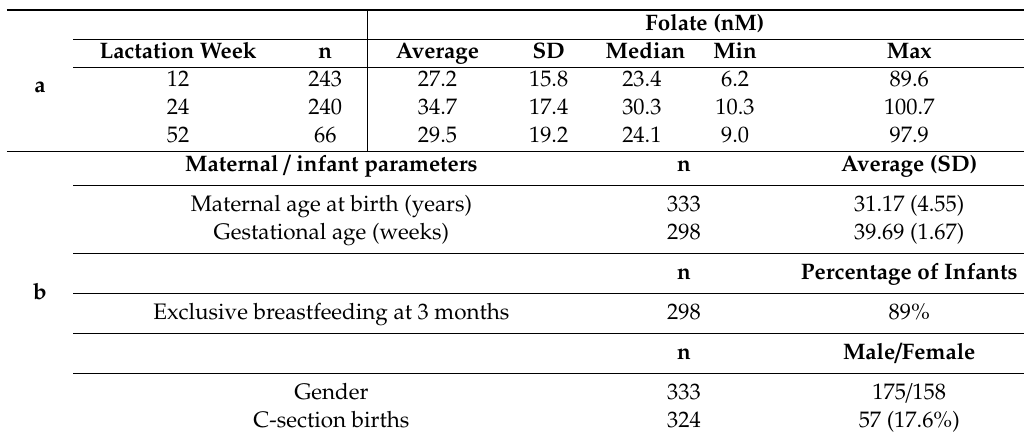
Table 2. ( a ) Folate levels in breast milk of German mothers at 3, 6, and 12 months of lactation. ( b ) Subject characteristics. At 3 and 6 months, 3 and 4 subjects respectively displayed folate levels above the upper limit of quantification and were thus not included in the table. n, number of subjects; SD, Standard